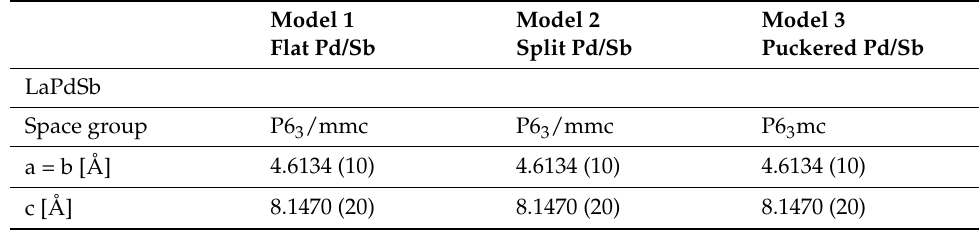
Table 1. Summary of crystallographic refinements for